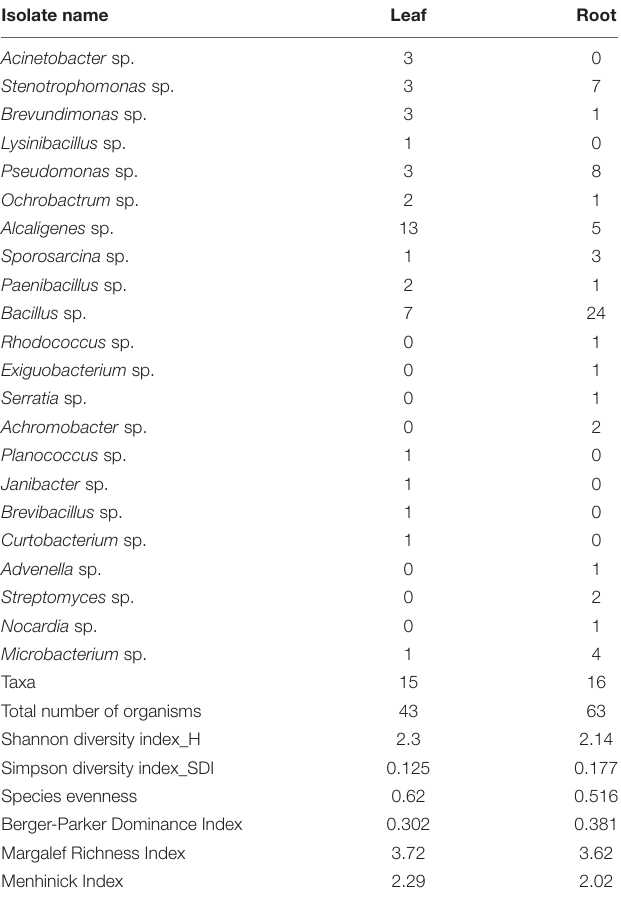
TABLE 2 | Population of endophytic bacterial isolates with diversity indices.